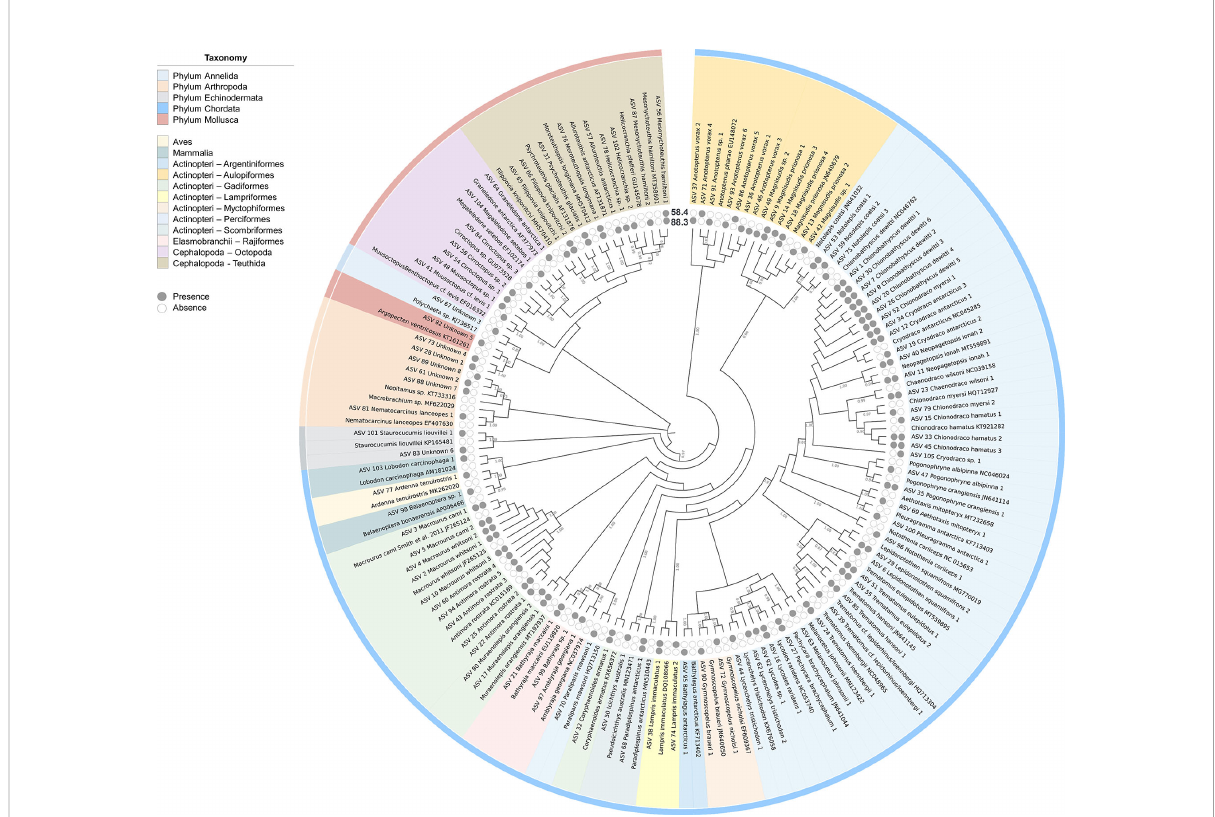
FIGURE 2 Prey haplotypes of Dissostichus mawsoni determined via metabarcoding analysis. A maximum-likelihood phylogenetic tree was generated using the prey haplotype of D. mawsoni and reference sequences in GenBank. A tree was created using MEGAX with a Kimura 2-parameter model and 1000 bootstrap replication. The tree was annotated in iTOL for taxonomy, haplotype presence, and bootstrap values (Letunic and Bork, 2021). Supplementary Data 2 includes information on the reference sequences used for phylogenetic